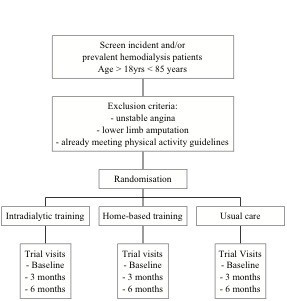
Flow chart of trial.